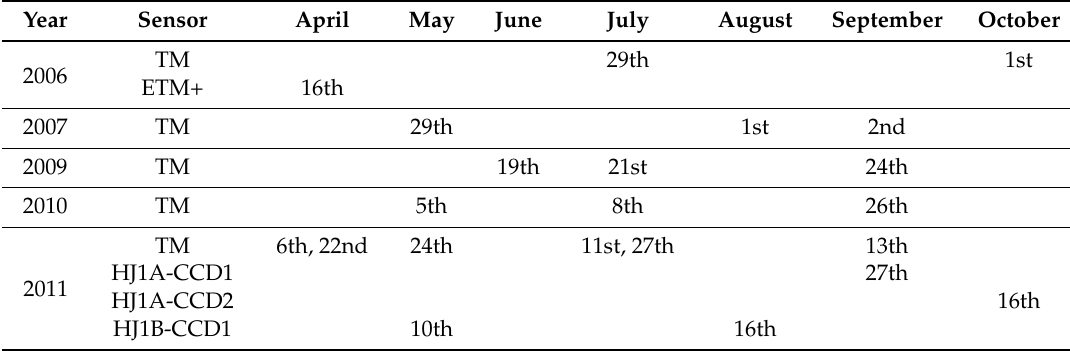
Table 1. The dates of Landsat TM/ETM+ and HJ images (in Bole).